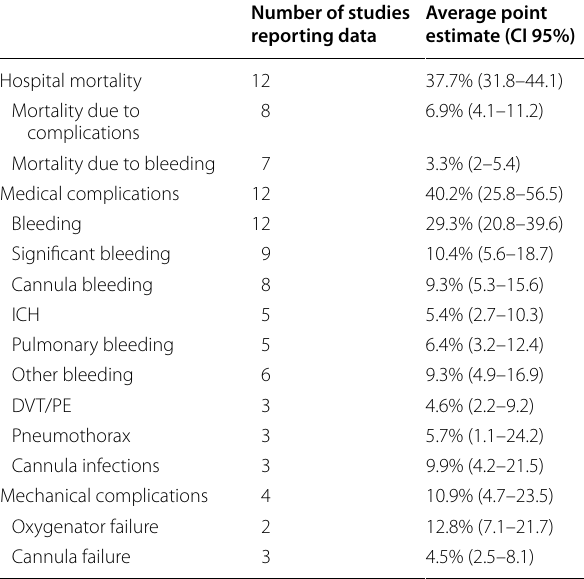
ICH intracerebral haemorrhage, DVT/PE deep venous thrombosis/pulmonary embolism